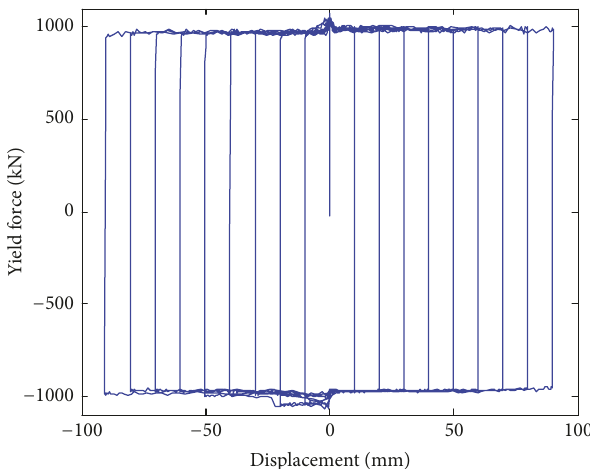
Figure 11: Numerical simulation results of